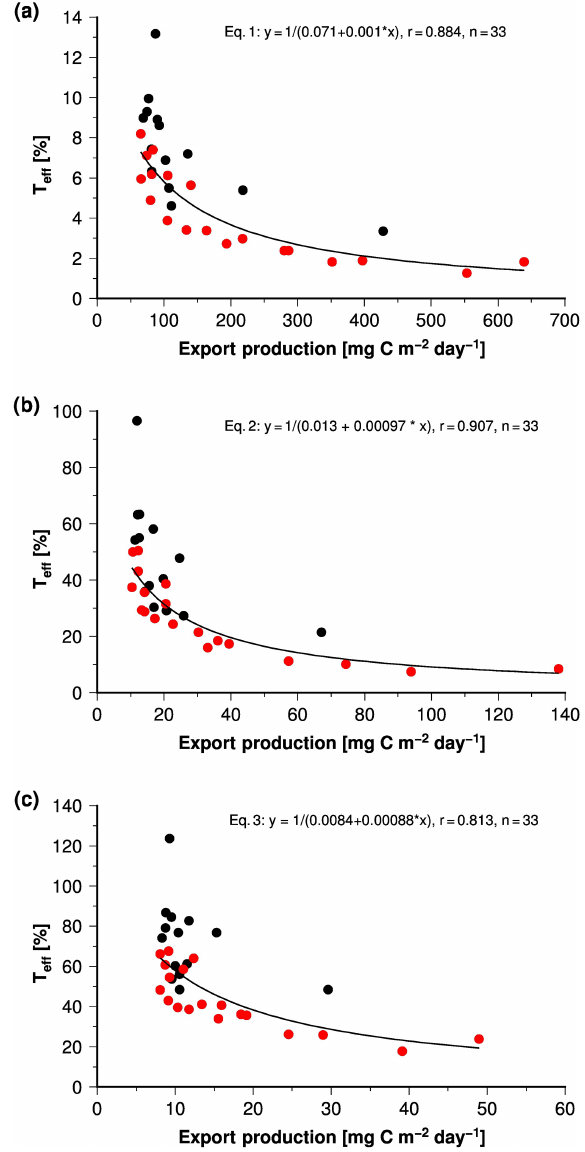
Figure 7. T eff versus export production rates derived from Eqs. (1) (a) , (2) (b) and (3) (c) . The red circles indicate samples associated with lithogenic matter content